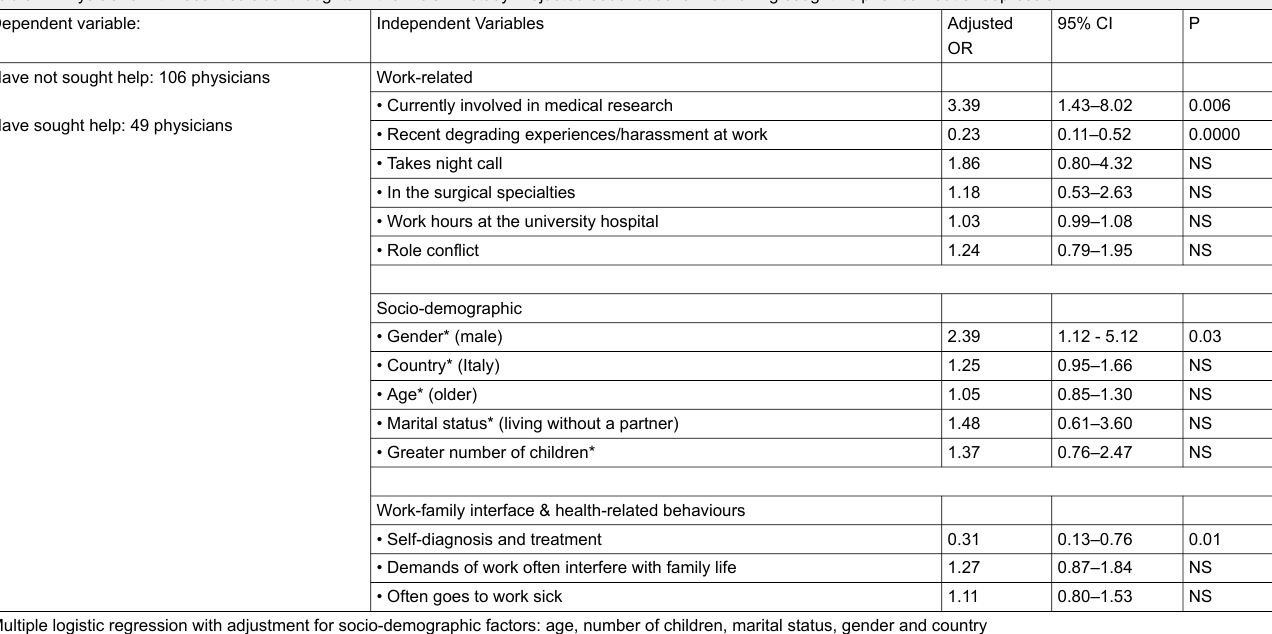
Table 2: Physicians with recent suicidal thoughts in the HOUPE study: Adjusted odds ratios for not having sought help for burnout or depression. Dependent variable: